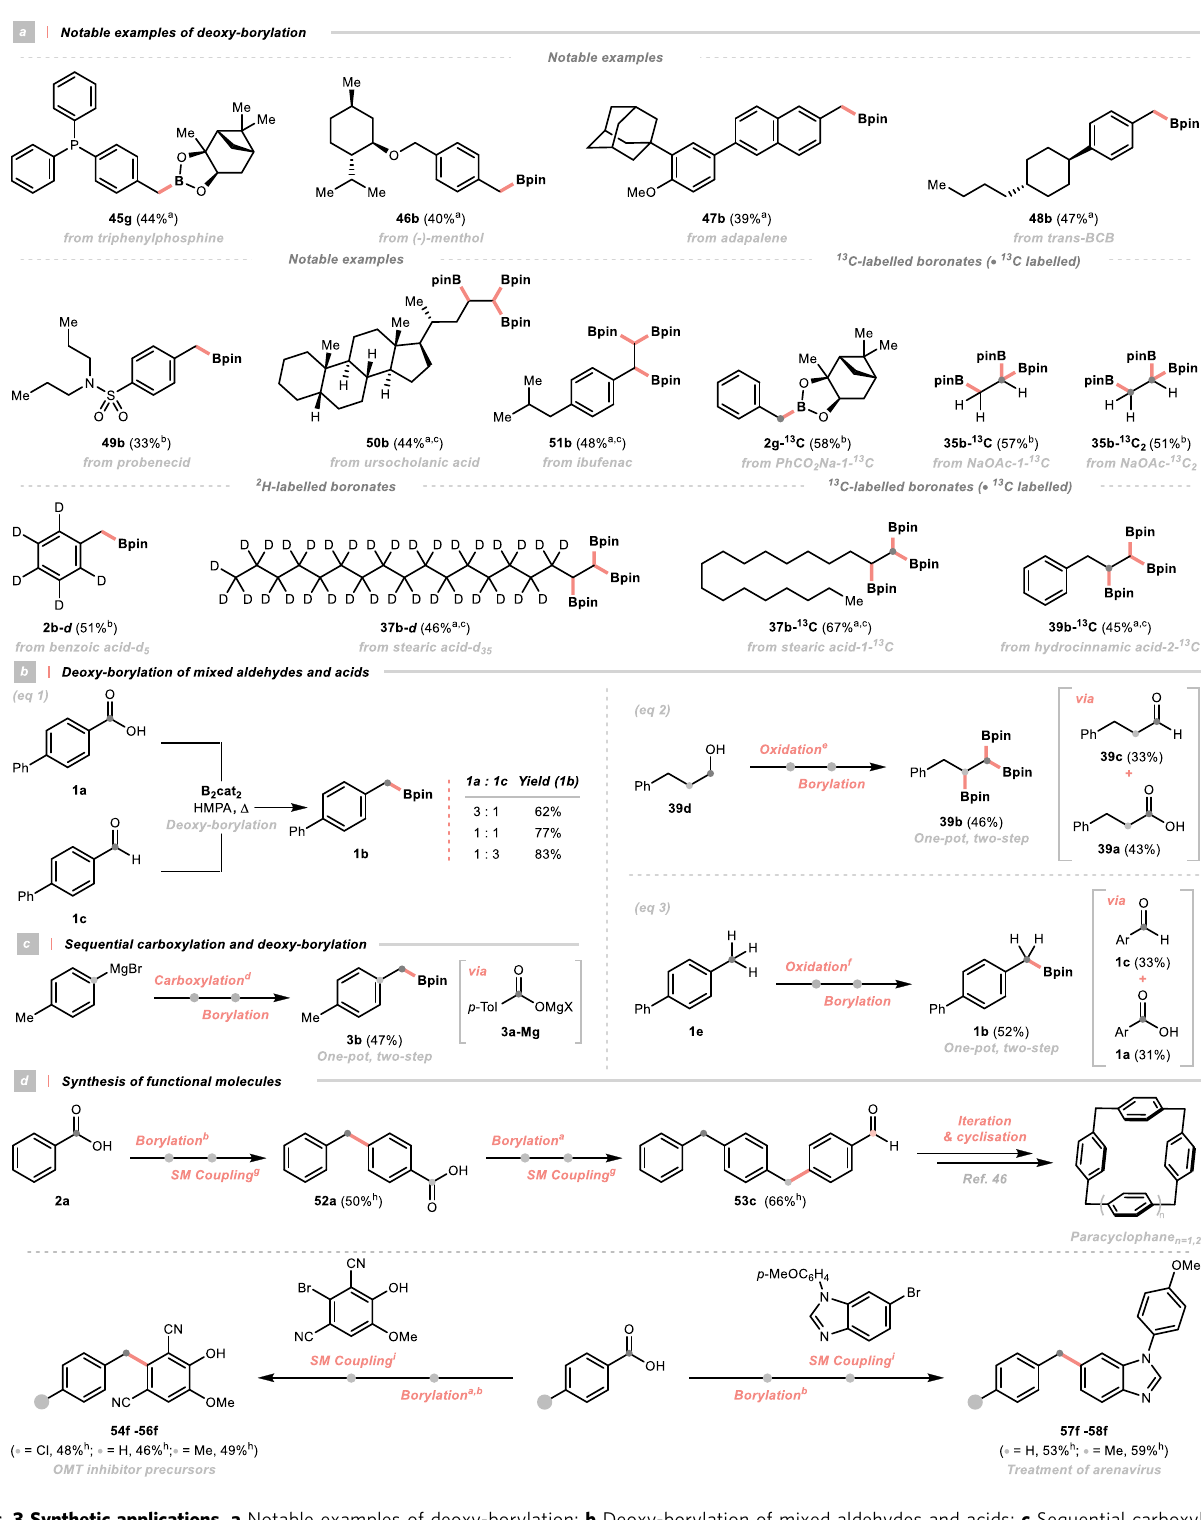
Fig. 3 Synthetic applications. a Notable examples of deoxy-borylation; b Deoxy-borylation of mixed aldehydes and acids; c Sequential carboxylation and deoxy-borylation; d Synthesis of functional molecules. For detailed conditions, see Supplementary Information. a Refer to Condition A in Fig. 2. b Refer to condition B in Fig. 2. c Refer to condition A in Fig. 2 but in DMA. d p -TolMgBr in Et 2 O under CO 2 atmosphere (1.0 atm) at from 0 °C to rt for 1.0 h. e Alcohol, Fe(NO 3 ) 3 ·9H 2 O, (2,2,6,6-tetramethylpiperidin-1-yl)oxyl (TEMPO), KCl in DCE under air at rt for 8.0 h. f NaSO 2 CF 3 in CH 3 CN under O 2 atmosphere (1.0 atm) with visible light at rt for 12 h. g R-BF 3 K, Ar-Br, Pd(dppf)Cl 2 ·CH 2 Cl 2 , Cs 2 CO 3 in THF/H 2 O under air and re fl ux for 24 h. h Yields refer to SM coupling. i R-Bpin, Ar-Br, Pd(dppf)Cl 2 ·CH 2 Cl 2 , NaHCO 3 in EtOH/H 2 O under air and re fl ux for 3.0 h. Bpin boronic acid pinacol ester, Bpnd boronic acid ( + ) − pinanediol ester, BCB 4-butylcyclohexylbenzoic acid, p -Tol p -tolyl, SM coupling Suzuki-Miyaura coupling, O MT O - methyltransferase, rt room temperature.